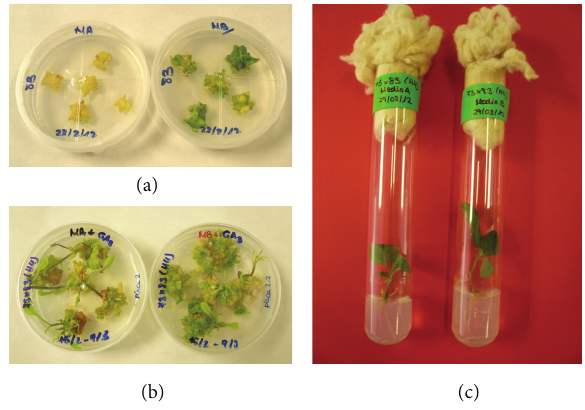
Figure 2: (a) Leaf explants of S. aethiopicum A1 at 20 days of culture on SIM-A (no response) or SIM-B (with buds). (b) Organogenic explants of the interspecific hybrid S. melongena × S. aethiopicum (M2 × A1) after 15 days of culture in the elongation medium. (c) ShootsofM2 × A1isolatedfromexplantsculturedonSIM-AorSIM- B rooted in MB medium (at 40 days of